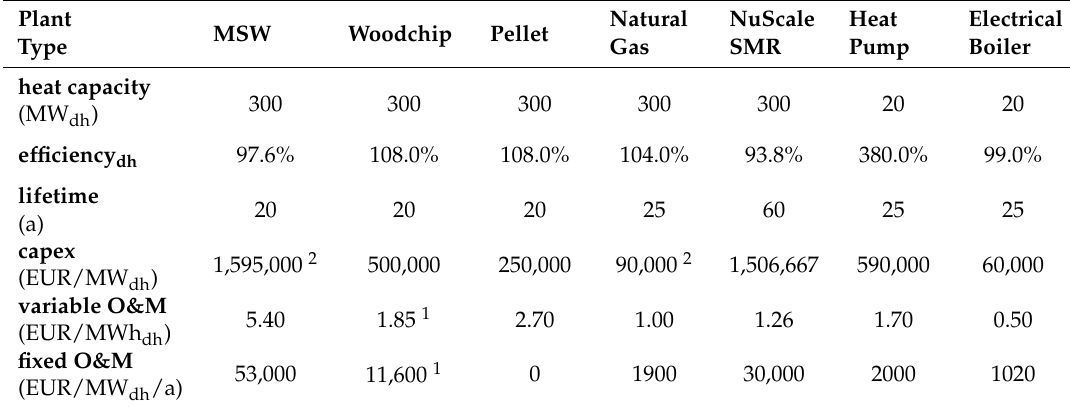
Table 1. Basic data for heat only plants used in this study [28,29].